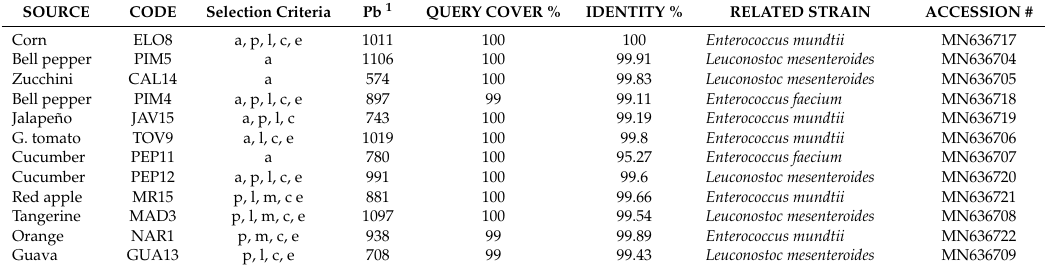
Table 5. Molecular identification of LAB isolated from fresh vegetable sources selected according to their antimicrobial and enzymatic activities.